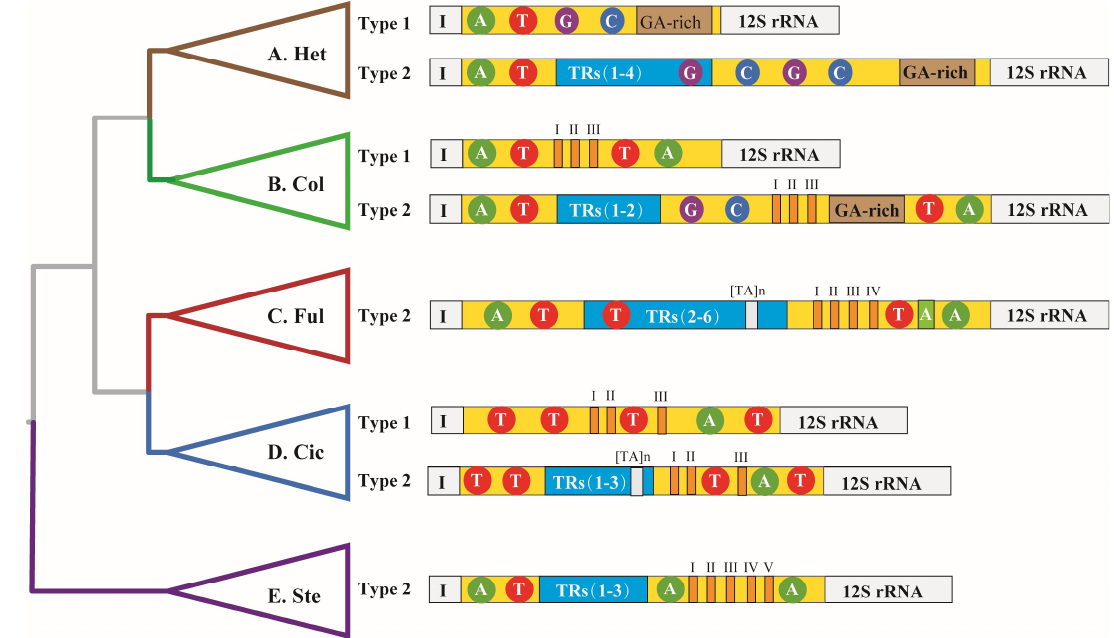
Figure 1. The structural organization pattern of the control region (CR) in Hemiptera groups. The CR is presented with a yellow long frame. Nucleotide stretches are shown in circles with different colors. The long A stretch is exhibited with a grass green bar; GA-rich regions are represented by brown bars; tandem replications (TRs) are shown by light blue bars with the different numbers; CSBs are shown by orange bars. TA is represented by white bar. Phylogenies of Hemiptera were used from the latest study [28]. Abbreviation: ( A ) Het: Heteroptera; ( B ) Col: Coleorrhyncha; ( C ) Ful: Fulgoromorpha; ( D )